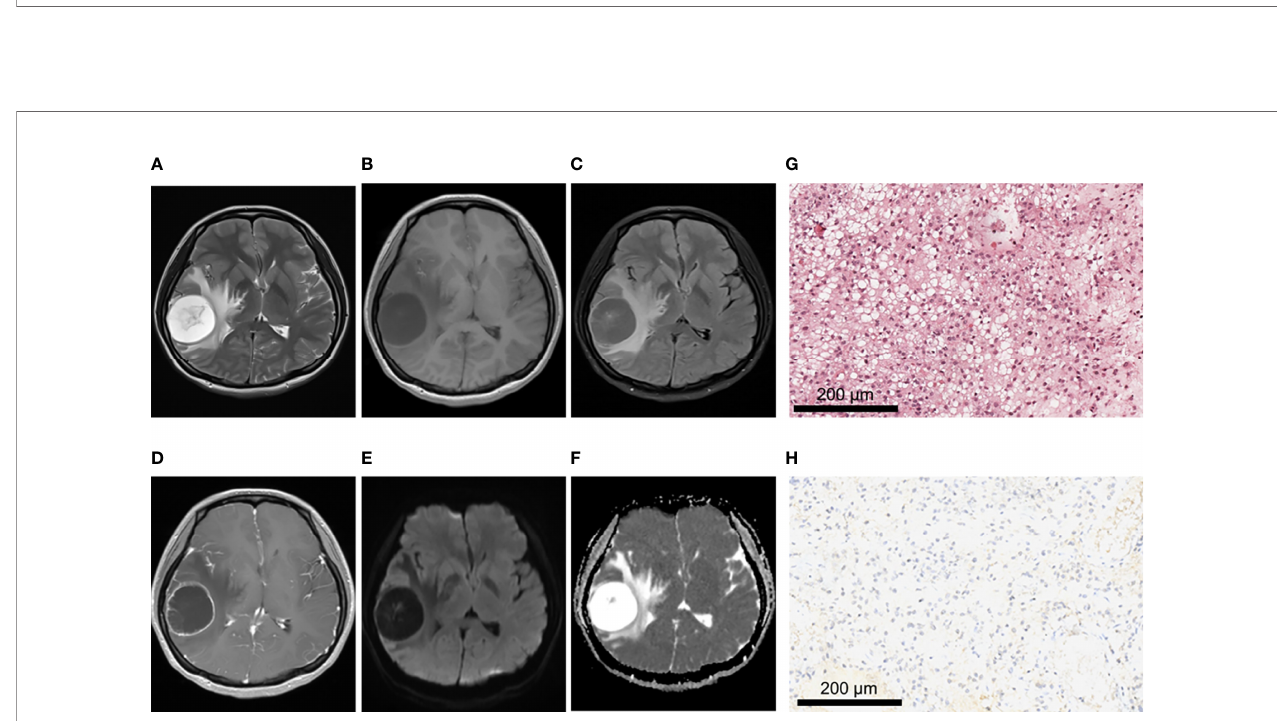
FIGURE 2 | A 28-year-old male patient with left frontal oligodendroglioma, WHO grade II, IDH-mutant type. (A – C) MRI axial T2W, T1W, and T2-FLAIR sequences showed clear tumor boundary, no cystic lesion, no hemorrhage, and no obvious edema around the tumor. (D) T1 postcontrast showed no obvious enhancement. (E, F) When b value was 1000, tumor was unrestricted diffusion in DWI and ADC images. (G) HE staining showed moderate increase in cell density, a small amount of nuclear atypia and loose background (×200). (H) IDH1 positive expression